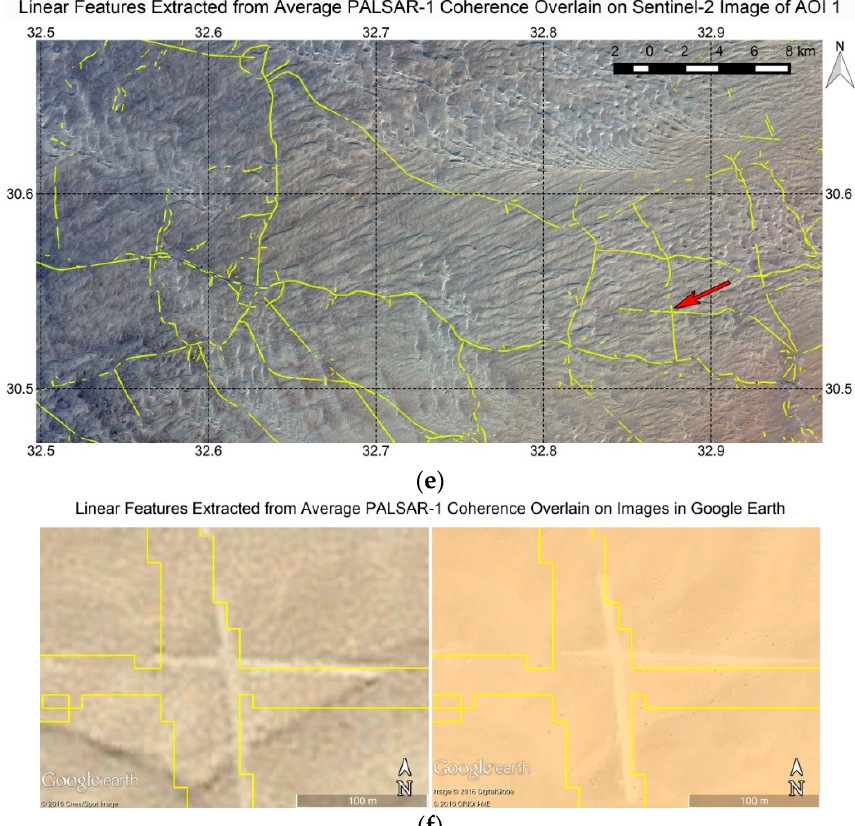
Figure 7. ( a ) Map showing subset region (AOI 1), marked by red rectangle, east of the Wadi Tumilat and west of Gebel Maghara; ( b ) average De Grandi filtered PALSAR-1 σ ° backscatter over AOI 1. This was initially used as input to the linear feature detection algorithm. PALSAR-1 data provided by ESA. ( c ) Average coherence of consecutive PALSAR-1 acquisitions over AOI 1. This was the final input to the linear feature detection algorithm. PALSAR-1 data provided by ESA. ( d ) Sentinel-2 image over AOI 1 with WMS vectors (roads) overlain. Image acquired on 19 February 2016. Full resolution (10 m) true colour composite of band 4 (650 nm) displayed as red, band 3 (543 nm) displayed as green, and band 2 (458 nm) displayed as blue. All vectors correspond to roads. The only WMS vectors other than roads include an administrative boundary, but given that this does not correspond to a physical object on the ground, it is not shown here. The colour coding corresponds to the presence of the vectors on the various WMS’: GM = Google Maps, OS = Open Street Map, BM = Bing Maps, AM = Apple iPhoto map. Contains modified Copernicus Sentinel data 2016. ( e ) Lines extracted from average PALSAR-1 coherence (in yellow) overlain on same Sentinel-2 subset image as in ( d ). Red arrow shows location of detail in ( f ). Contains modified Copernicus Sentinel data 2016. ( f ) Detail of partially buried crossroads on optical remotely sensed images available on Google Earth acquired on 7 February 2007 ( left ) and 5 May 2010 ( right ). Lines extracted from average PALSAR-1 coherence overlain in yellow. The centre of the crossroads, as identified in the SAR imagery, is located at 30.539° latitude and 32.877° longitude. The crossroads is an example of a feature not present on any of the available WSM vector layers. It appears unchanged from 2007 to 2010 and is visible in multitemporal speckle filtered PALSAR-1 imagery also from 2007 to 2010. The width of the vectors shows the coarse resolution of the PALSAR-1 average coherence image with respect to the VHR imagery on Google Earth. However, despite the PALSAR-1 coherence pixel spacing far exceeding the width of the roads, the crossroads nonetheless appears far more clearly on the PALSAR-1 average coherence than on any of the available optical layers.